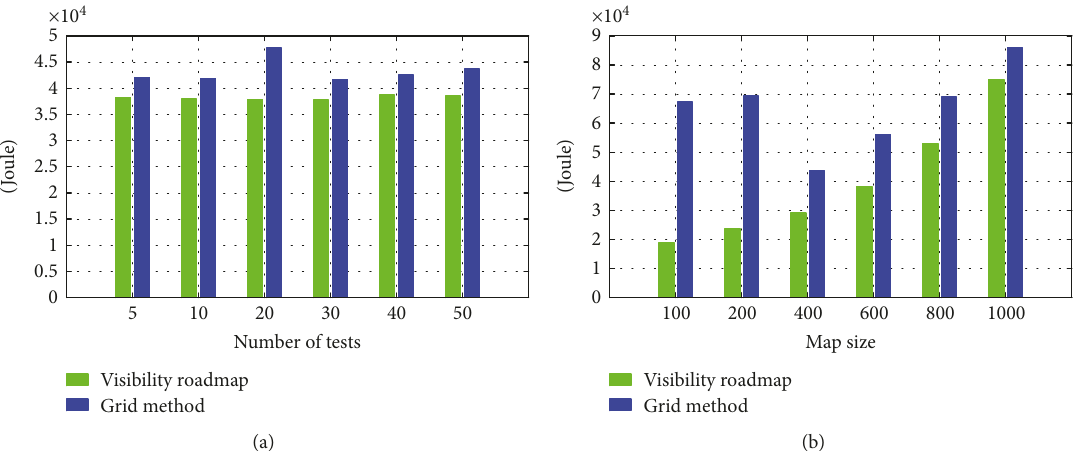
Figure 11: Comparison of two algorithms regarding energy consumption: (a) based on number of tests in Table 5; (b) based on map size in Table 6.